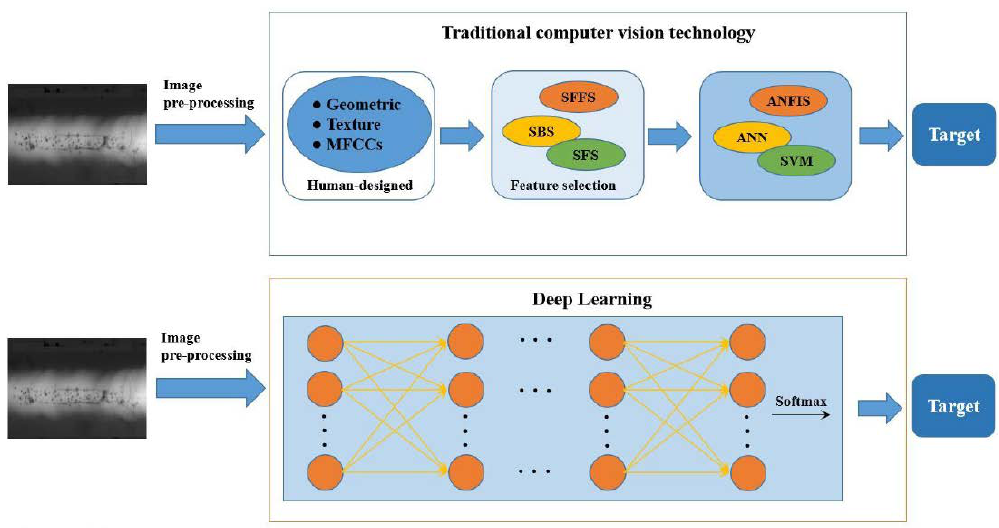
Figure 4. Traditional computer vision technology and deep learning approach